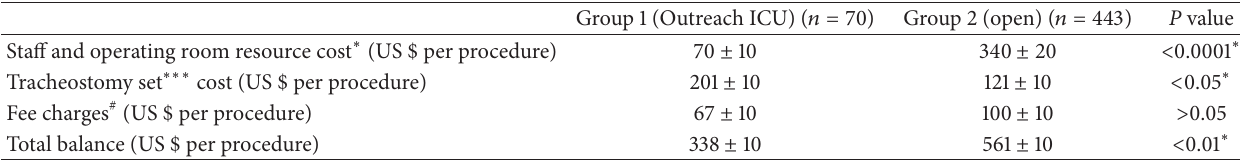
Table 4: Economic rationale of PDT technique versus open surgical method in operating room (mean ±